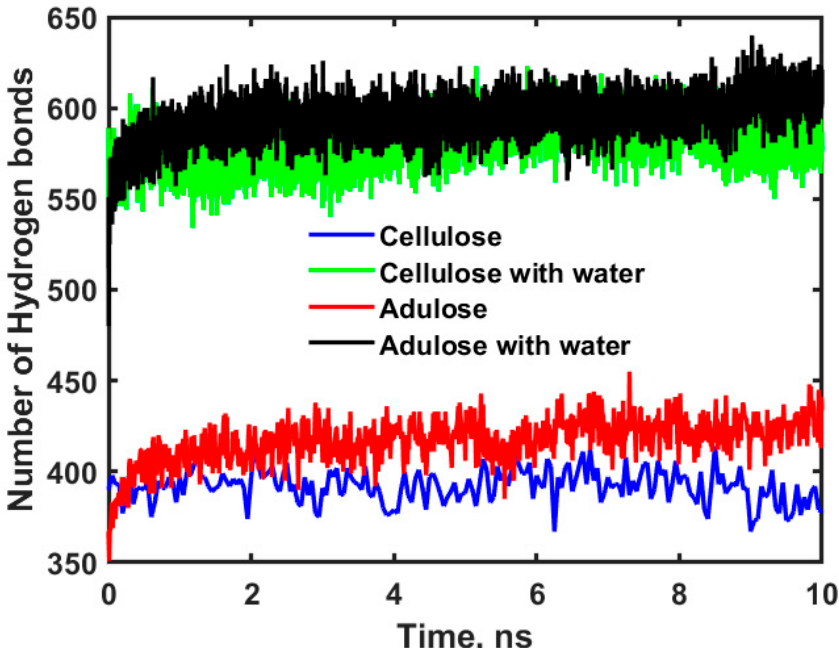
Figure 6. Time versus number of hydrogen bonds for cellulose, cellulose with water, adulose, and adulose with water systems.